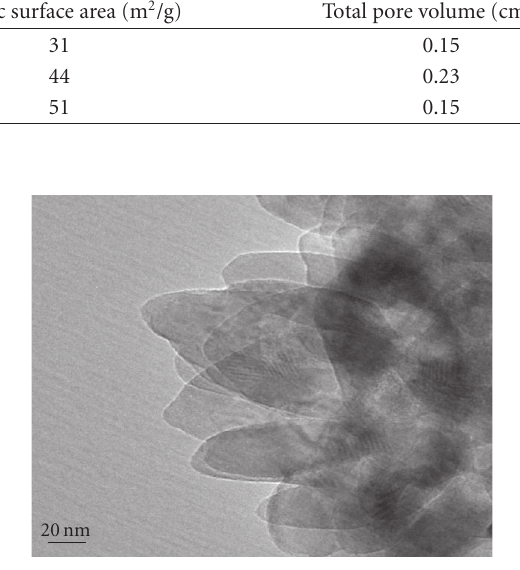
Figure 3: N 2 -physisorption curves recorded at 77 K for the R70 TiO 2 catalyst.